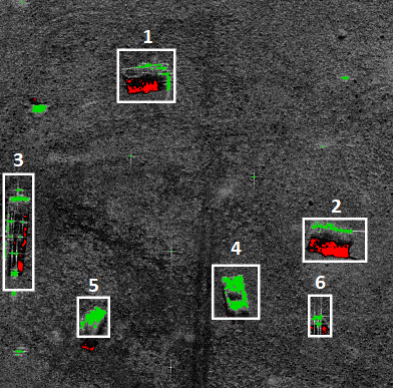
Figure 4. Extracted part of the image of the group of